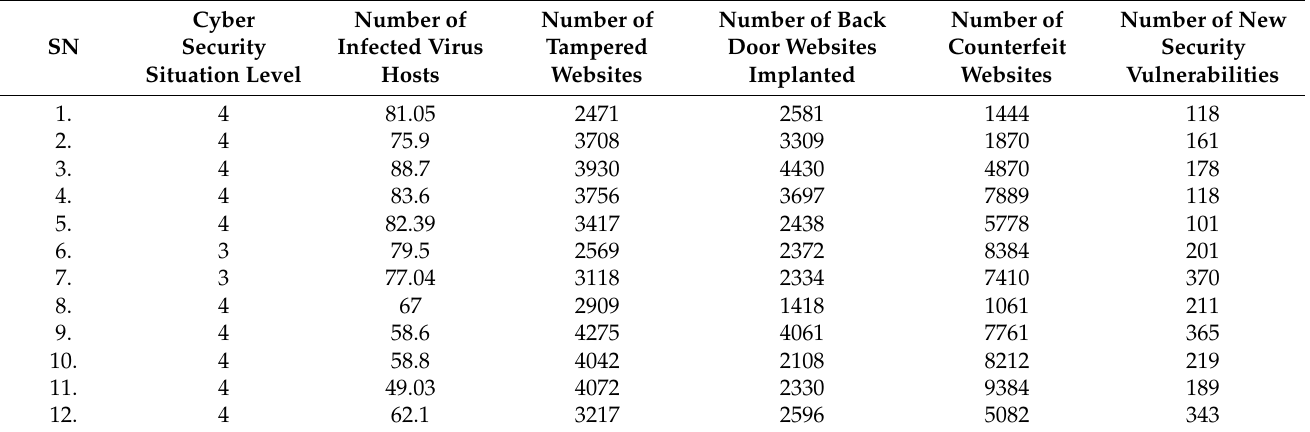
Table 1. Data sample.